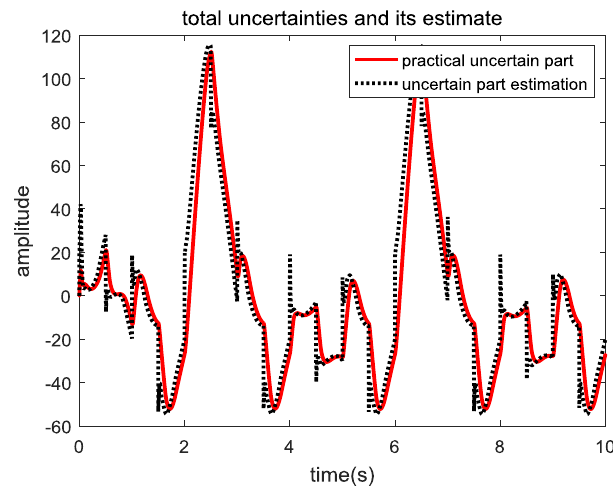
Figure 13. External disturbances and ESO prediction results.